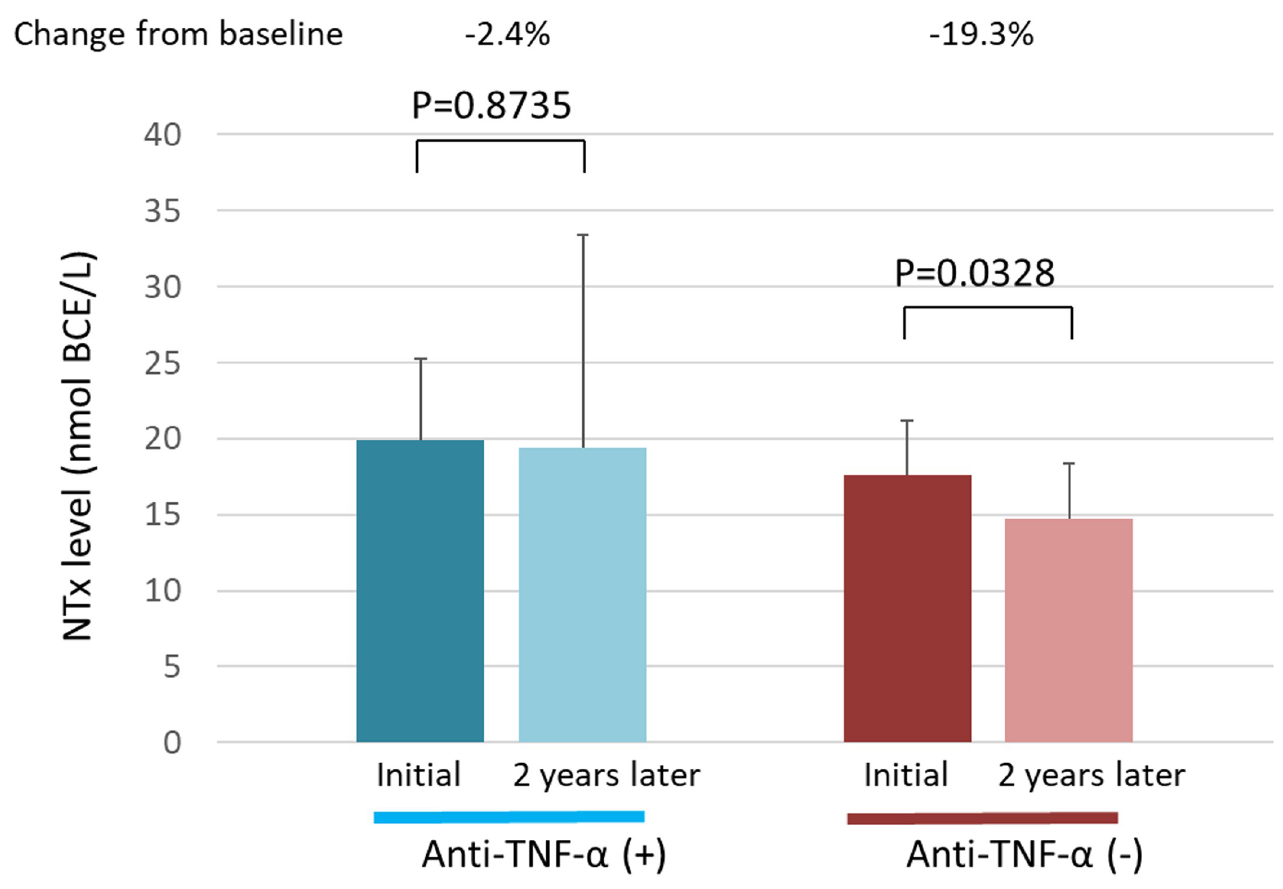
Fig 3. Serum NTx levels in the anti-TNF- α administration and non-administration groups. The serum NTx levels at the first measurement and 2 years later are shown for each group. NTx, N-terminal telopeptide of type I collagen; TNF- α , tumor necrosis factor α .